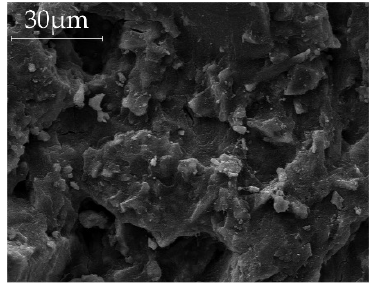
Figure 8. SEM picture after a hydration period of 28 days, of a mixture with GGBFS and